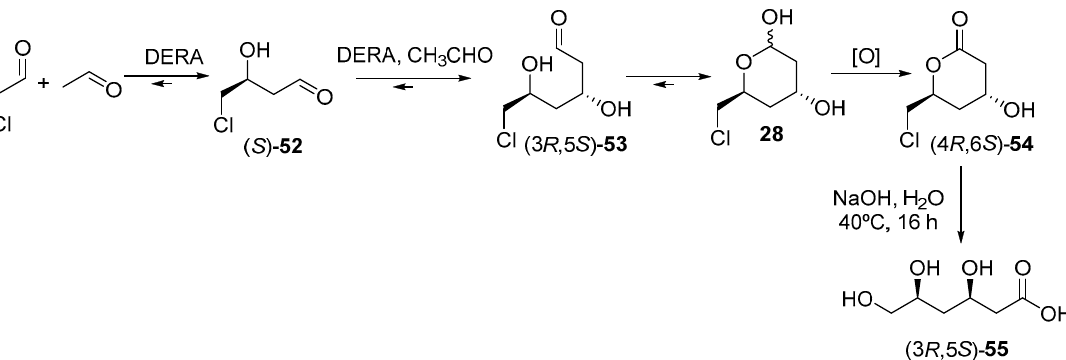
Figure 14. Aldolase-catalysed synthesis of chiral building blocks for statins.